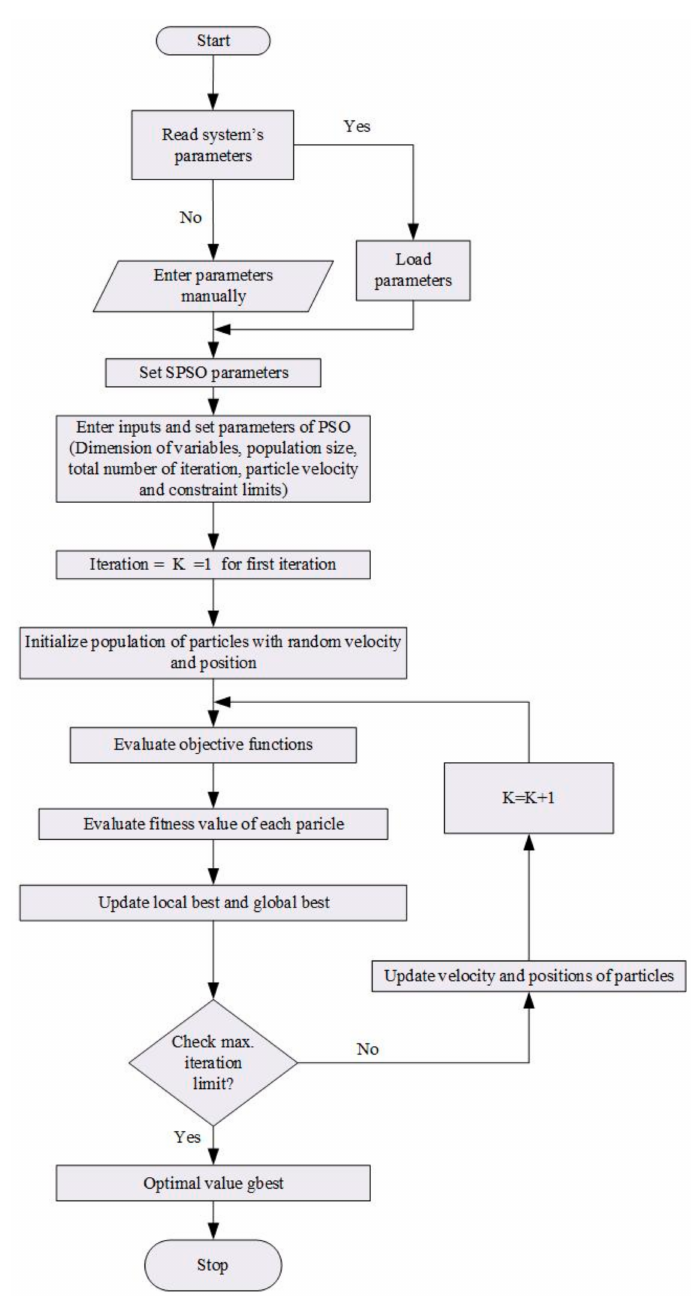
Figure 2. Flow chart for the devised